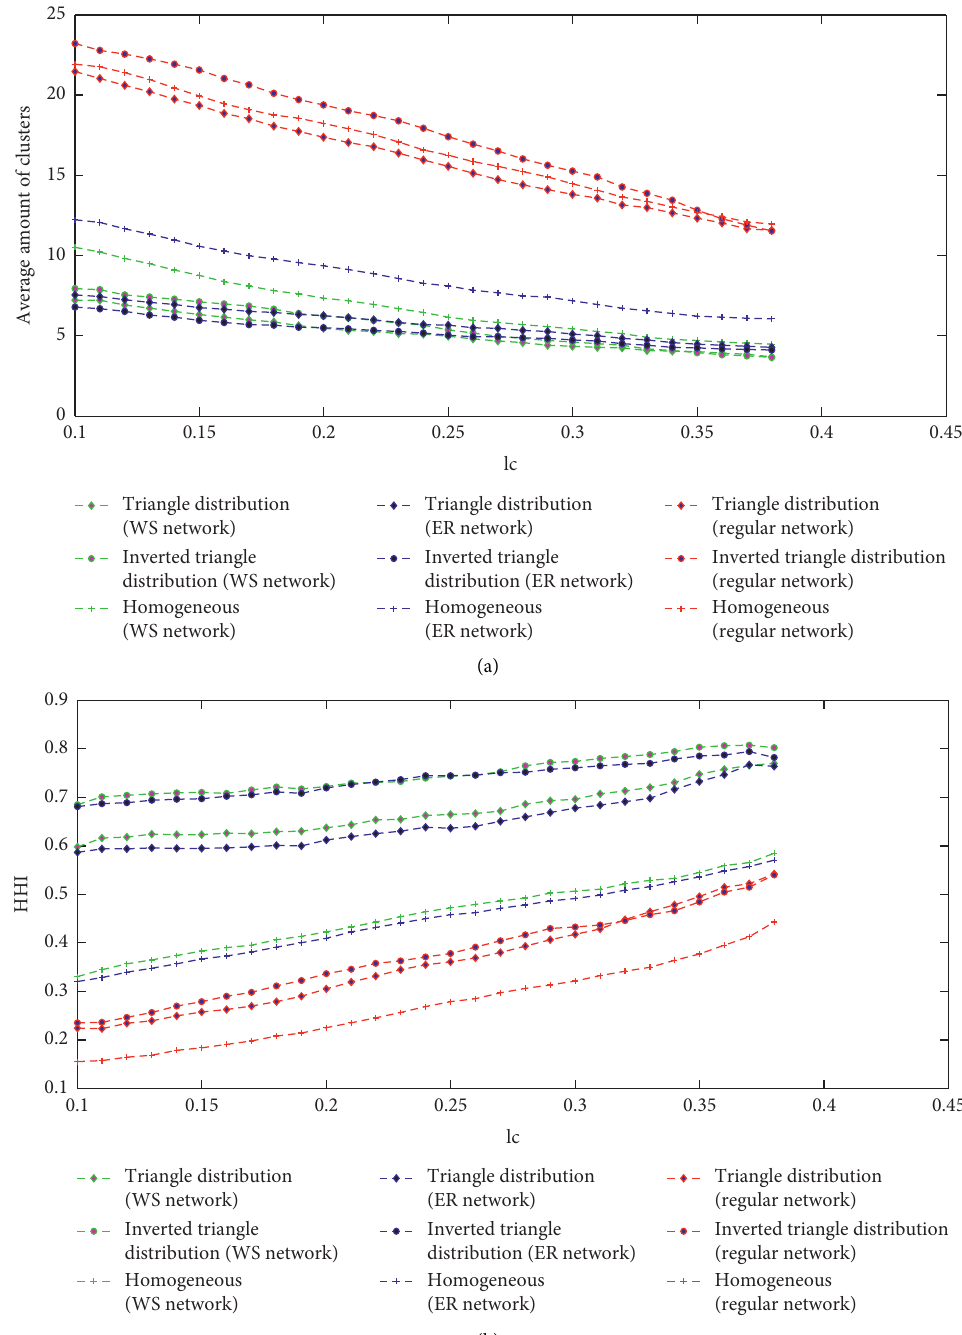
Figure 4: Influence of l c on the AOC and HHI under different network